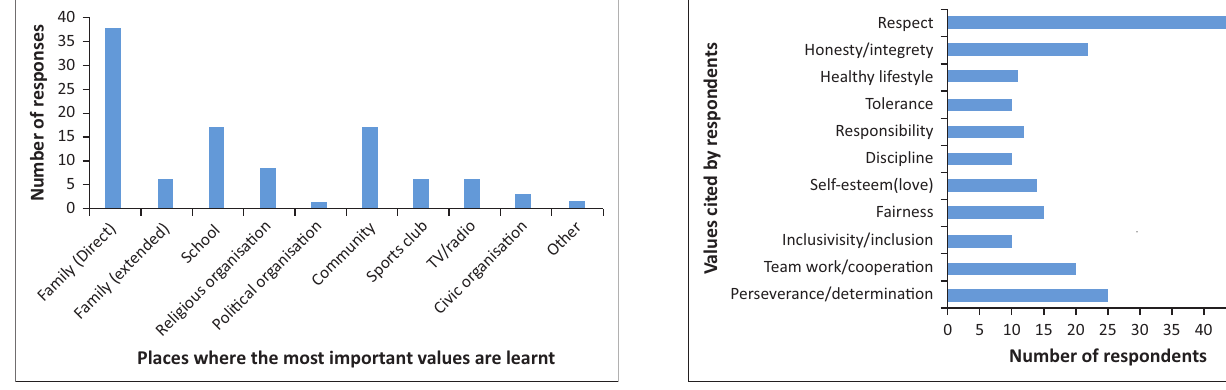
FIGURE 1: The most important place where values are learnt.